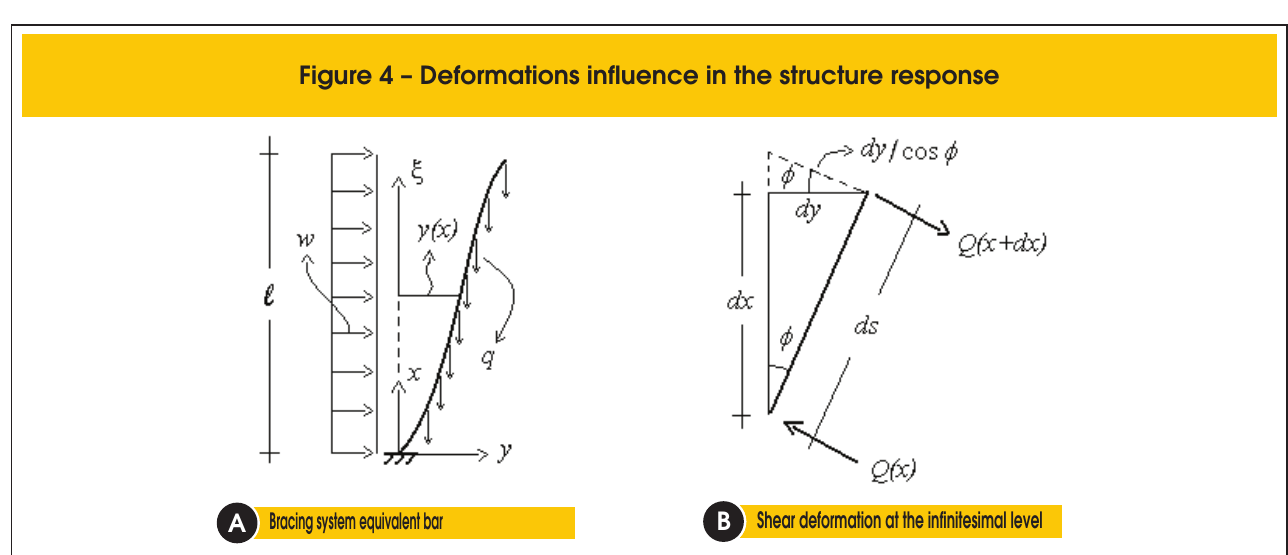
Figure 4 – Deformations influence in the structure response